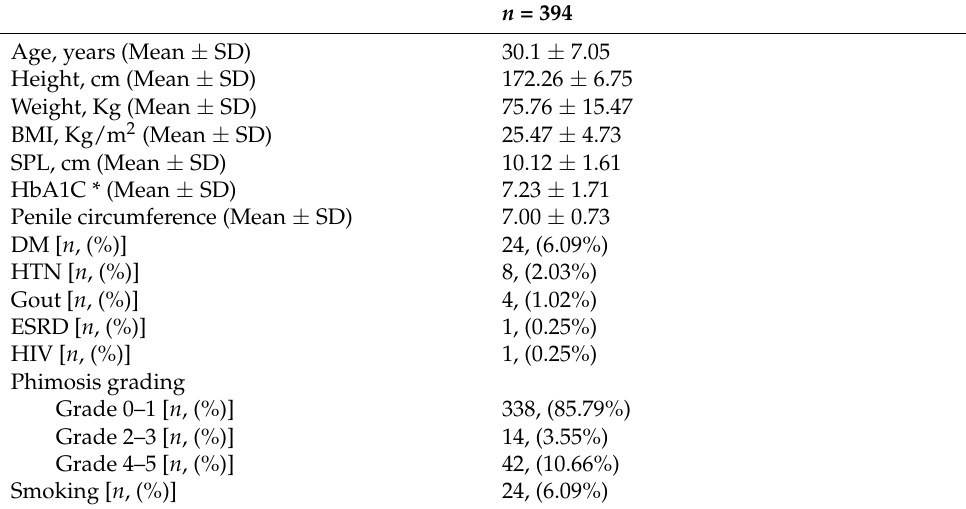
Table 1. Demographic data.